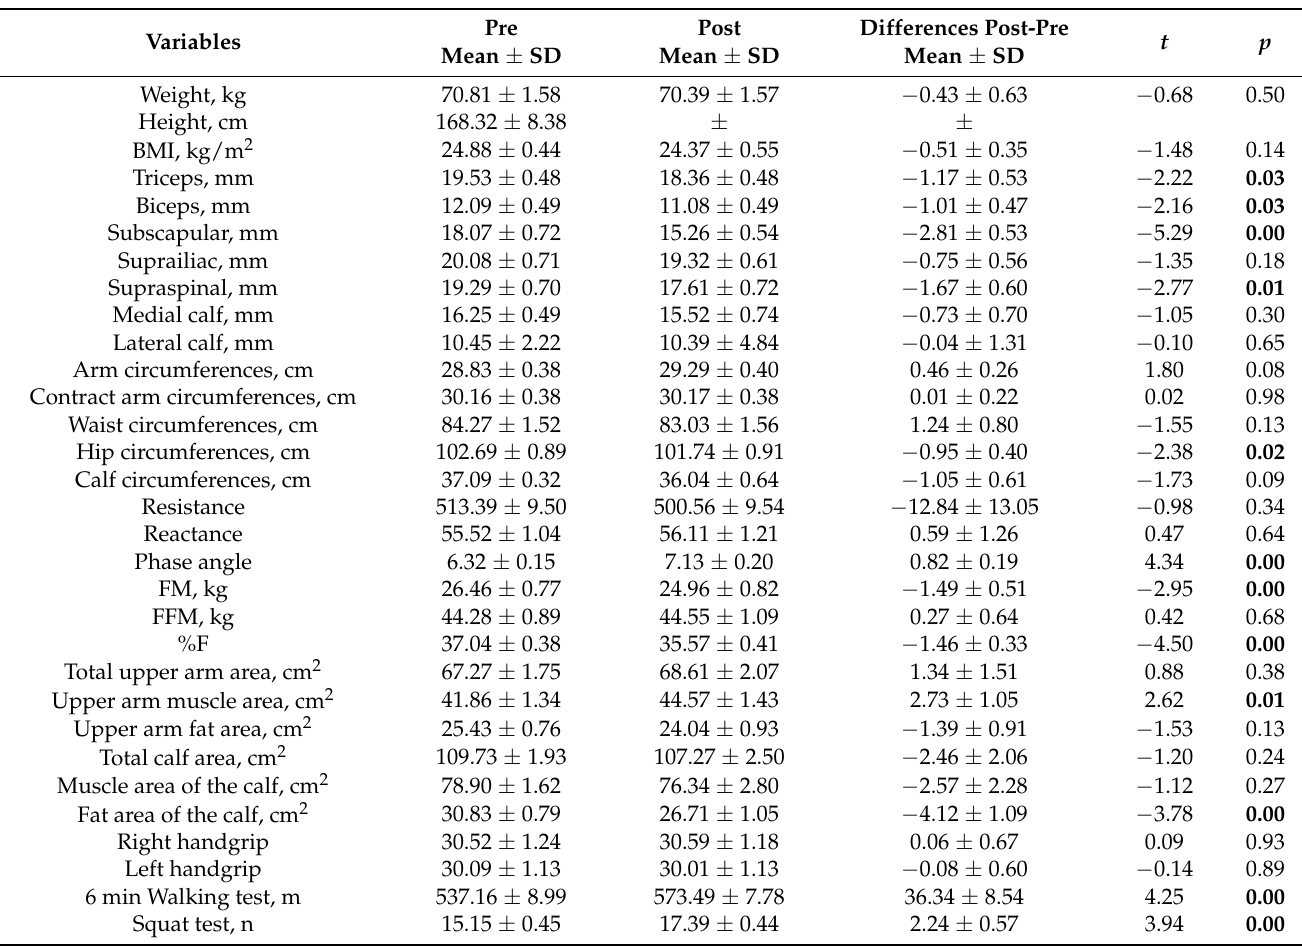
Table 1, and women and men characteristics are presented in Table 2. Table 1. Paired Students’ test and entire sample’s anthropometric measures, body composition and physical test